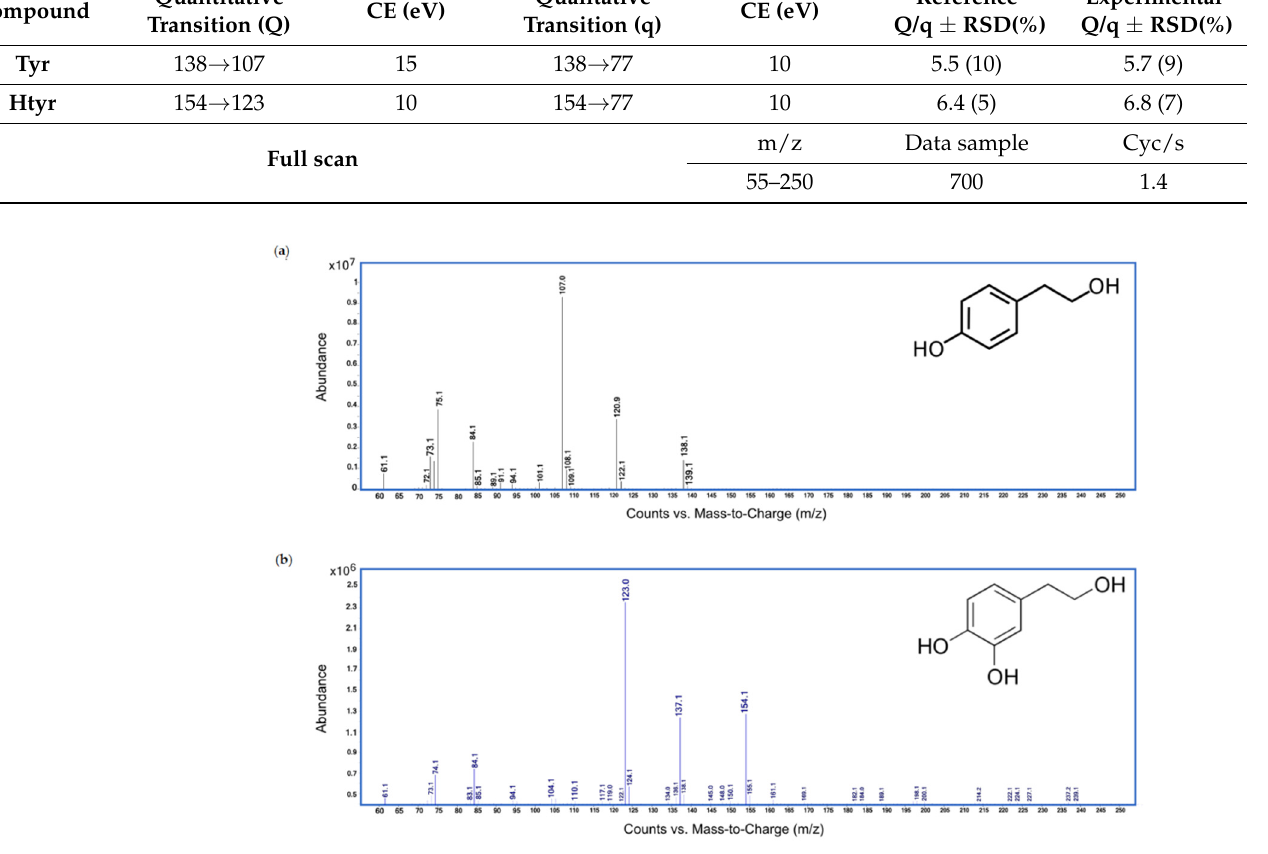
Figure 1. Structures and LEI–MS spectra of ( a ) Tyr and ( b ) Htyr.